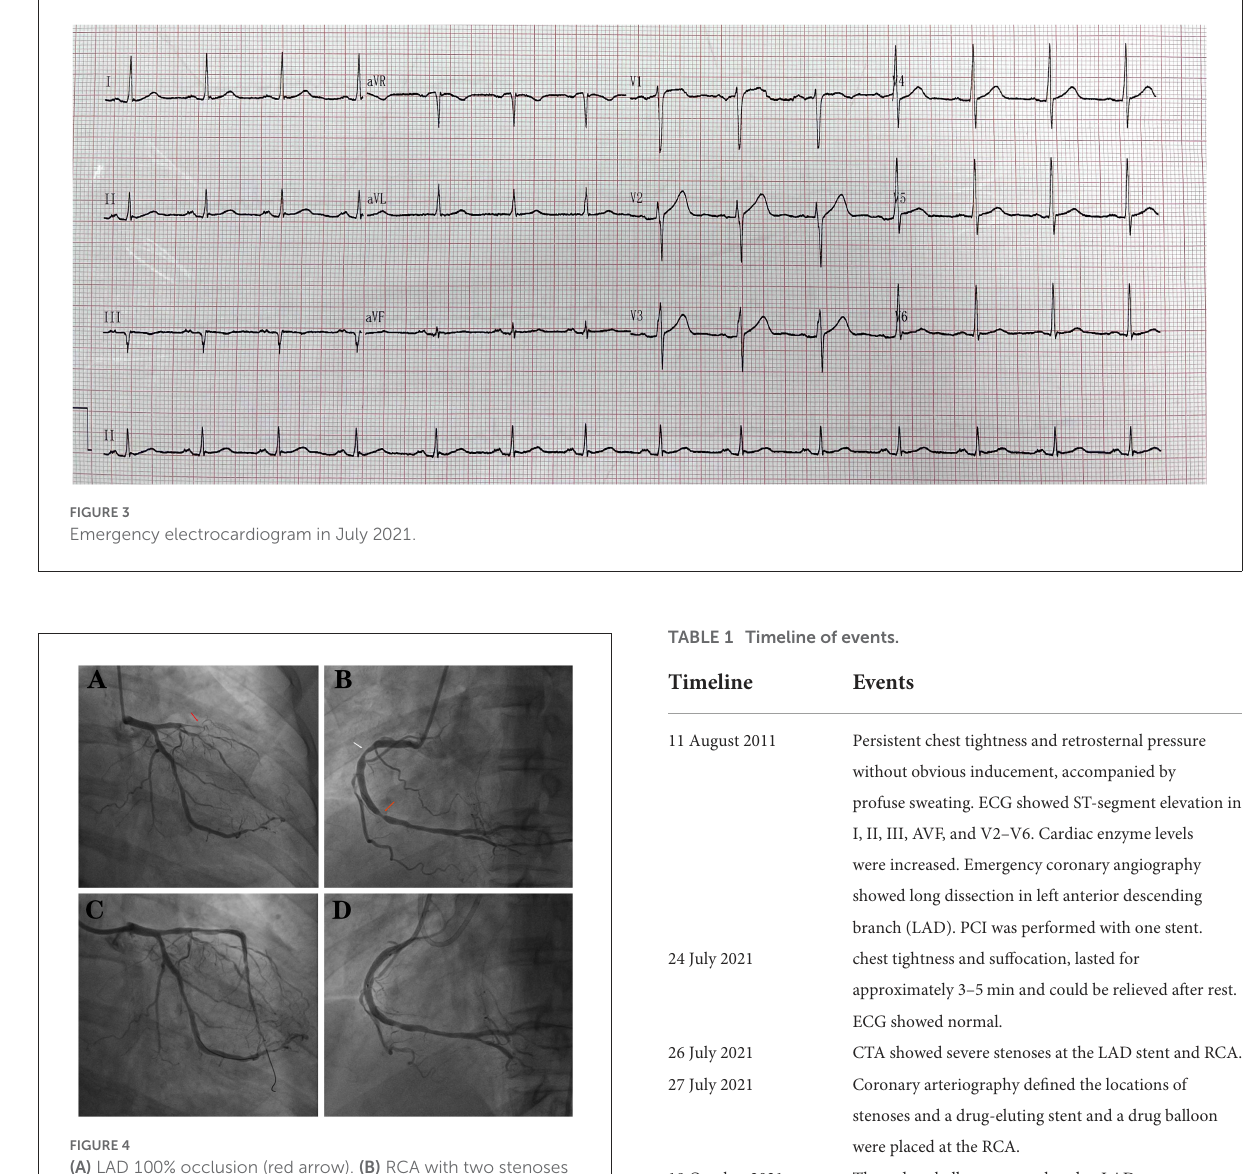
FIGURE4 (A) LAD 100% occlusion (red arrow). (B) RCA with two stenoses (red and white arrows). (C) LAD after implantation of 3 drug